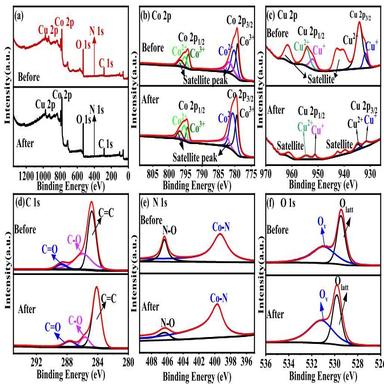
XPS profiles of the as-prepared 5%Cu2+-Co3O4/NC-GL-600 sample and the sample being used for five times toward advanced oxidation reaction of PNP.